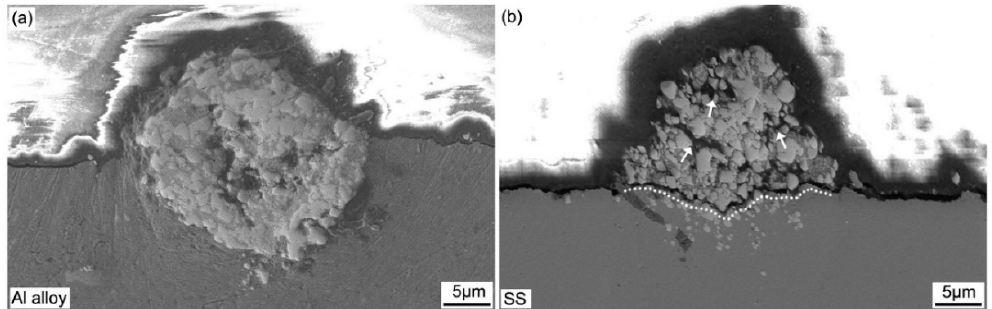
Figure 4. SEM imaging of cross-section of a WC-Co particle after deposition on ( a ) Al alloy and ( b ) SS substrates.